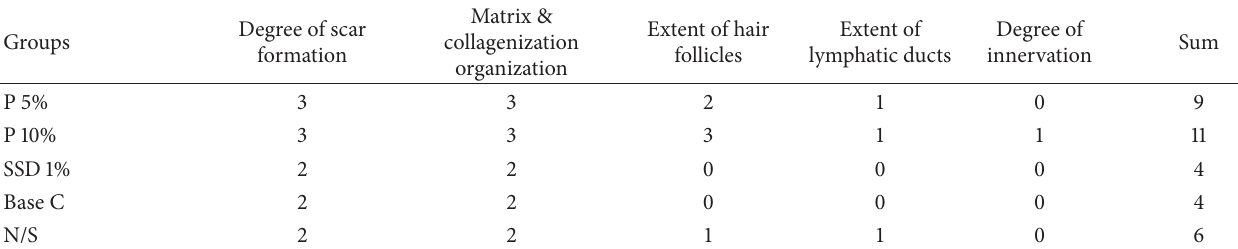
∗ Silver sulfadiazine 1 % (SSD 1 % ), normal saline (N/S), base cream (BC), Punica granatum flowers cream 5 % (P 5 % ), and Punica granatum flowers cream 10 % (P 10 % ). These samples were taken randomly from each group.